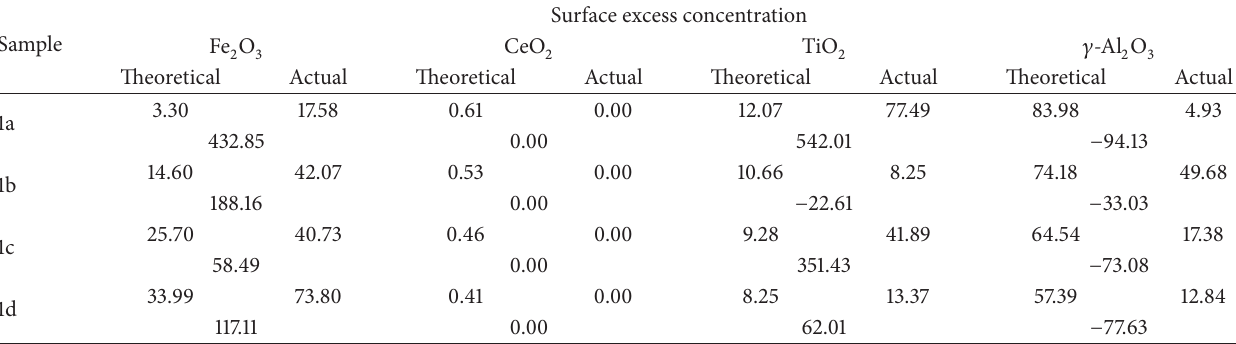
Table 8: EDAX analysis with surface excess concentration.